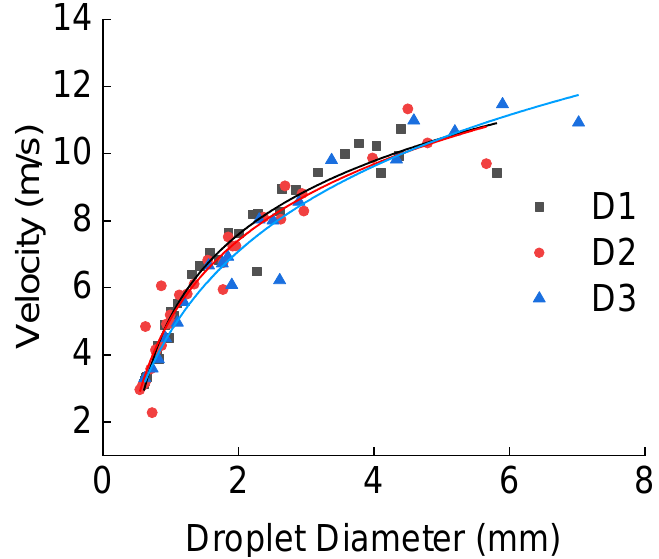
Figure 16. Relationship between droplet velocity and diameter sprayed from diamond nozzles with different aspect ratios. (D1, D2, and D3 refer to the diamond nozzles with aspect ratios of 1.54, 1.32, and 1.11, respectively).